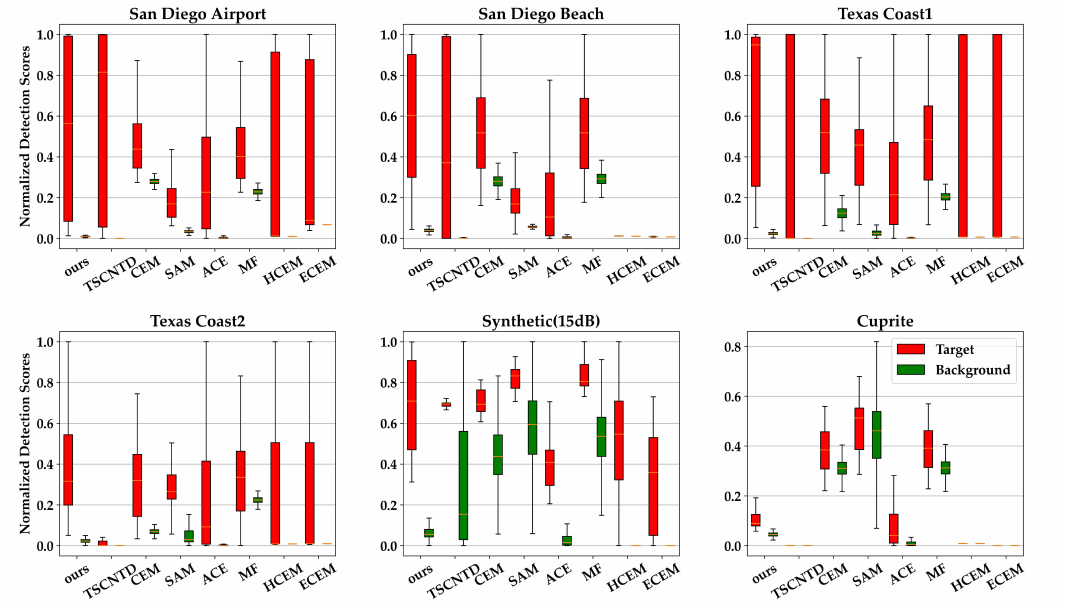
Figure 10. Boxplots of all the test algorithms on the six data sets. Each algorithm has two boxes on each data set. The red and green boxes represent the confidence distributions of target pixels and background pixels, respectively. The top of the boxes are the upper quartiles. The upper black lines and middle orange lines are the upper bounds and means of the distributions,